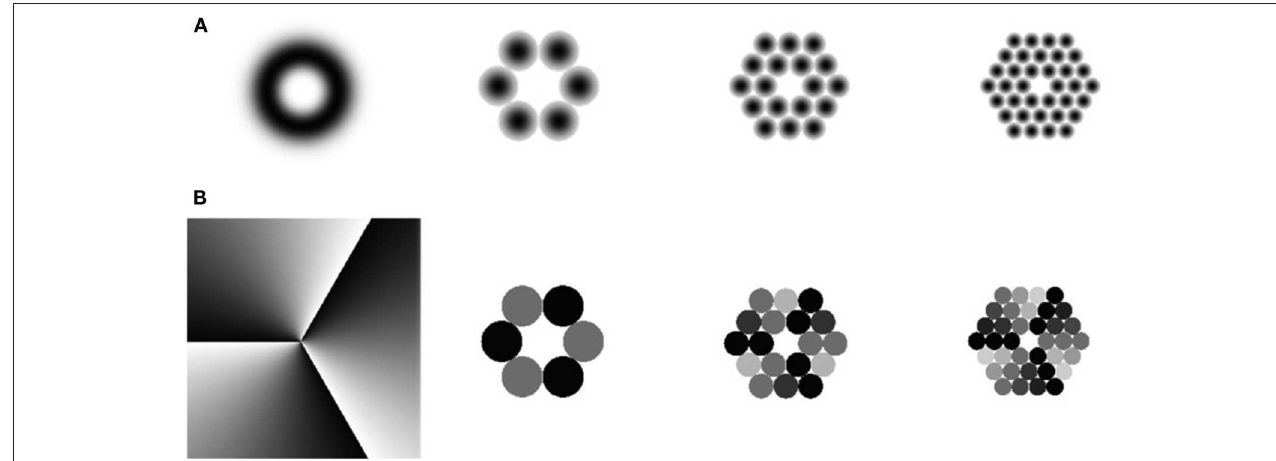
FIGURE 1 | (A) Amplitude and (B) phase distributions of the fields of Laguerre –Gaussian (Equation 5) and synthesized vortex (Equations 1–4) beams with a topological charge l 3 =